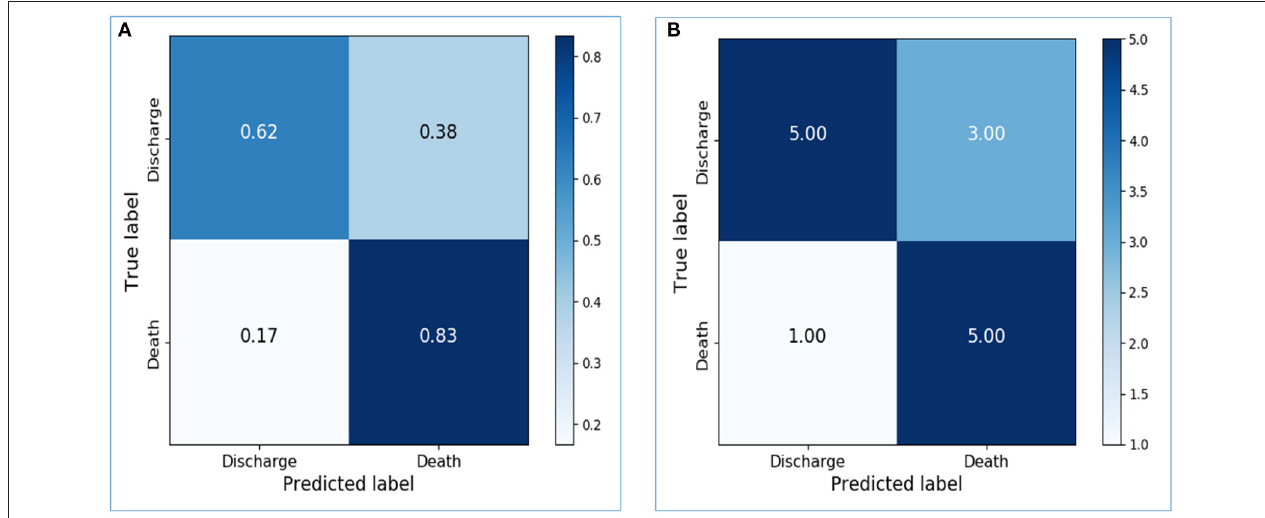
FIGURE 4 | Confusion matrices of the preliminary prediction model. (A) : Confusion matrix of the testing dataset, with normalization. (B) : Confusion matrix of the testing dataset, without normalization.